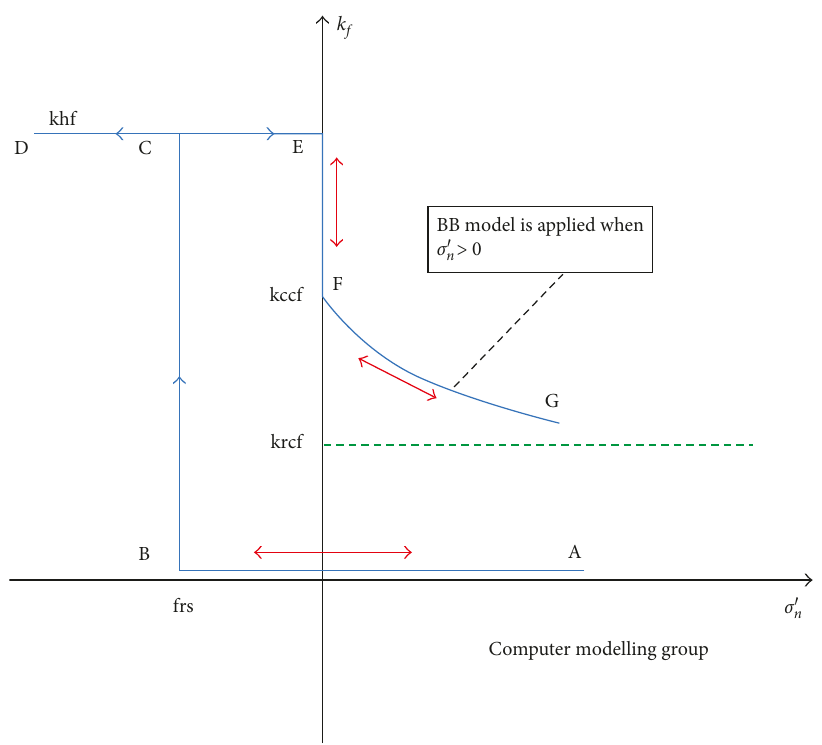
Figure 1: Modified Barton–Bandis model for the change in fracture